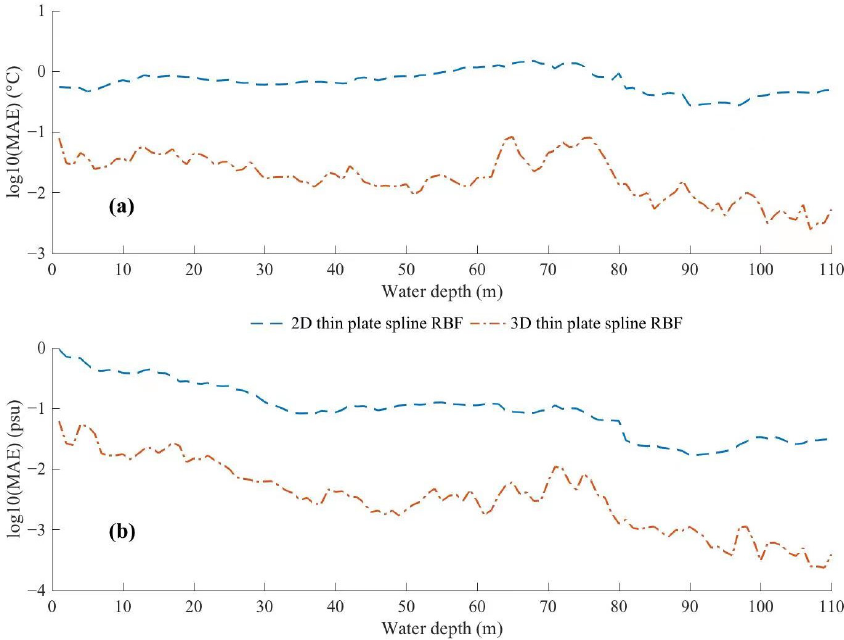
Figure 10. The log 10 (MAE) at different depths with 2D and 3D thin plate spline RBF methods, respectively. The blue dash-dot line is the 2D thin plate spline RBF method while the orange dash-dot line is the 3D thin plate spline RBF method. ( a ) Temperature, ( b ) Salinity.